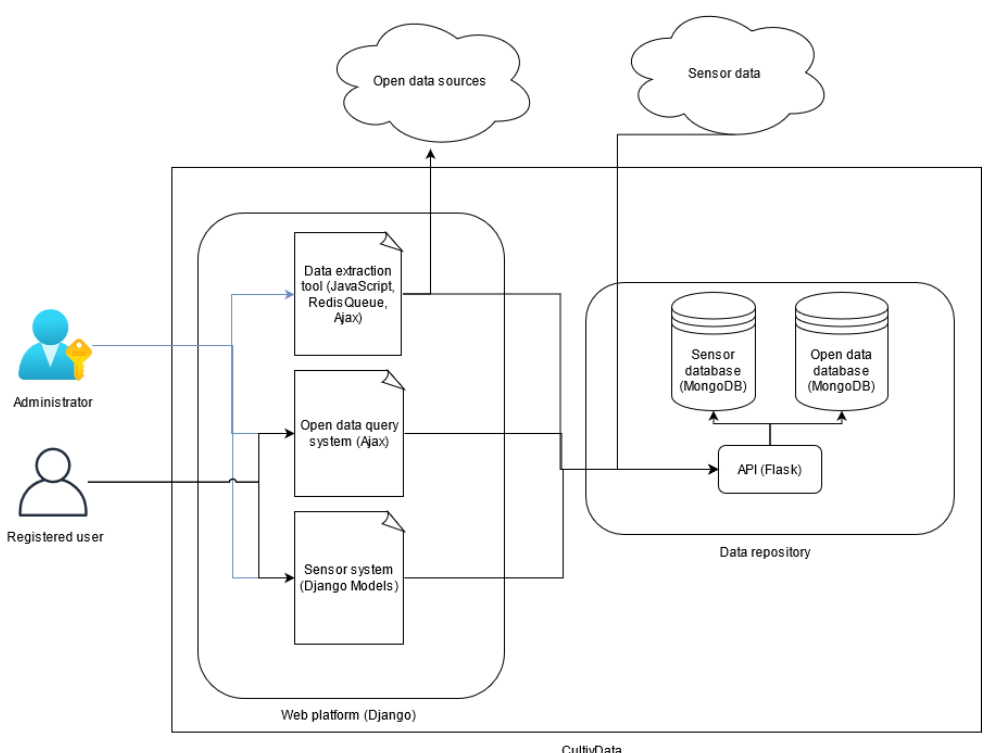
Figure 3. Detailed diagram of the system